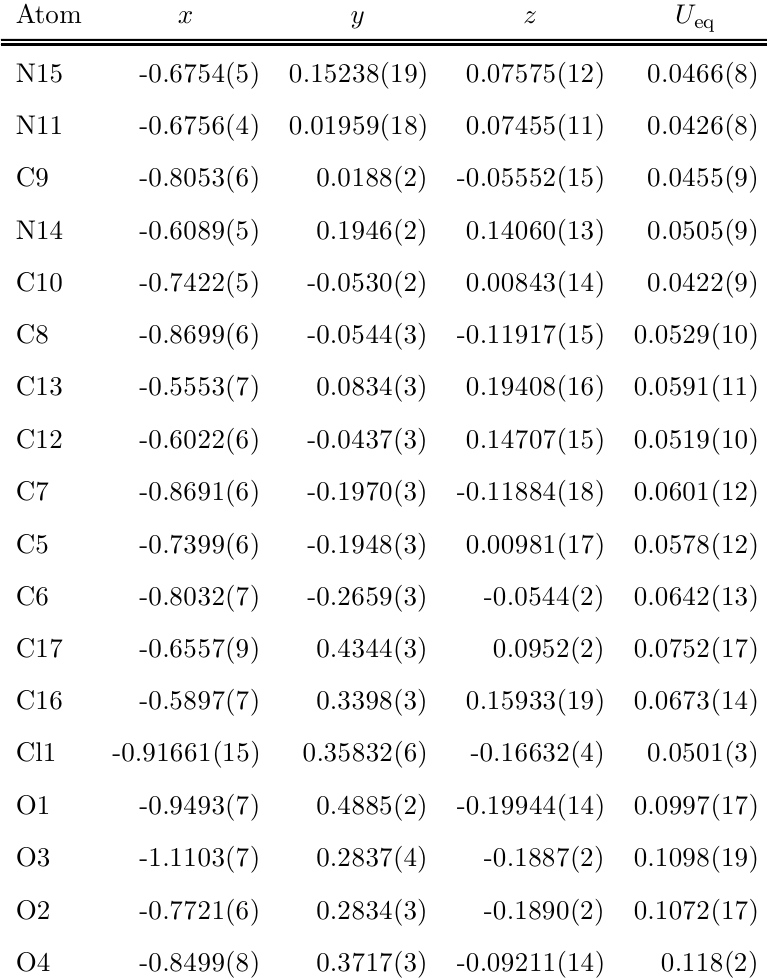
Table 3 Atomic coordinates and equivalent thermal